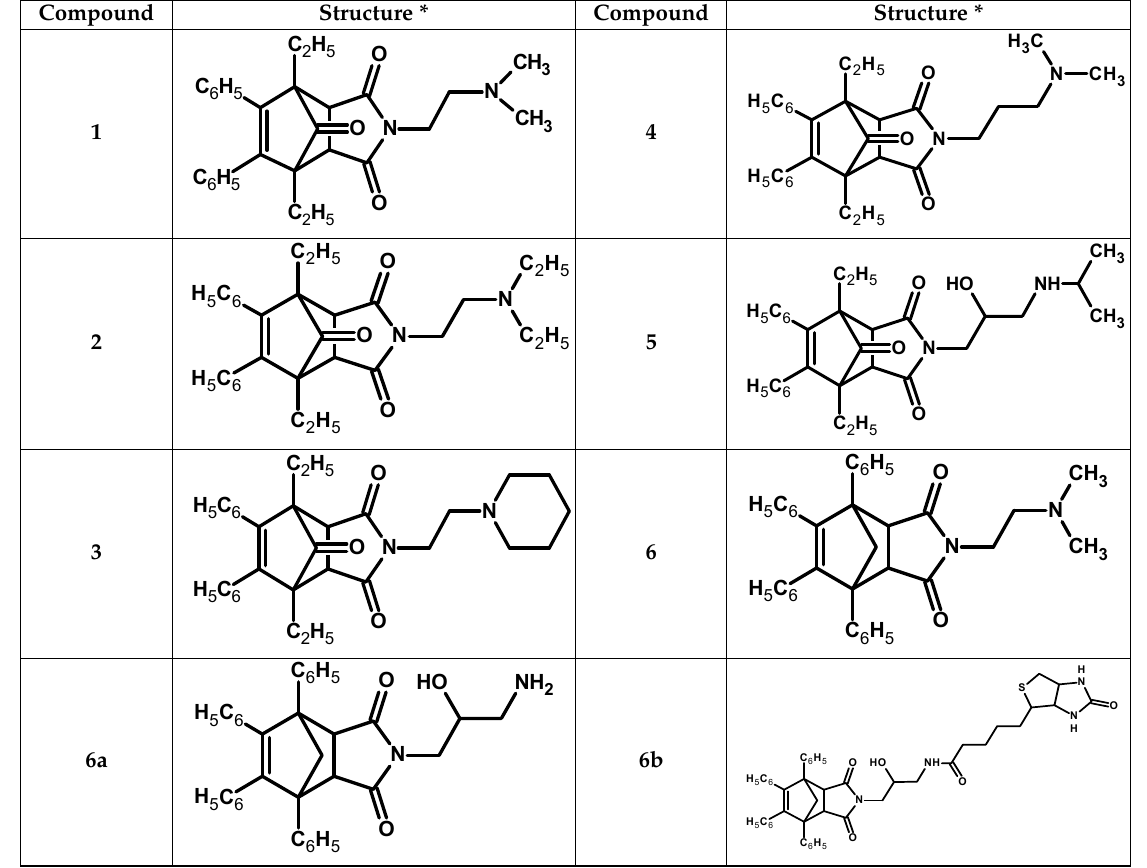
Table 1. Chemical structure and the numbering of dicarboximides.